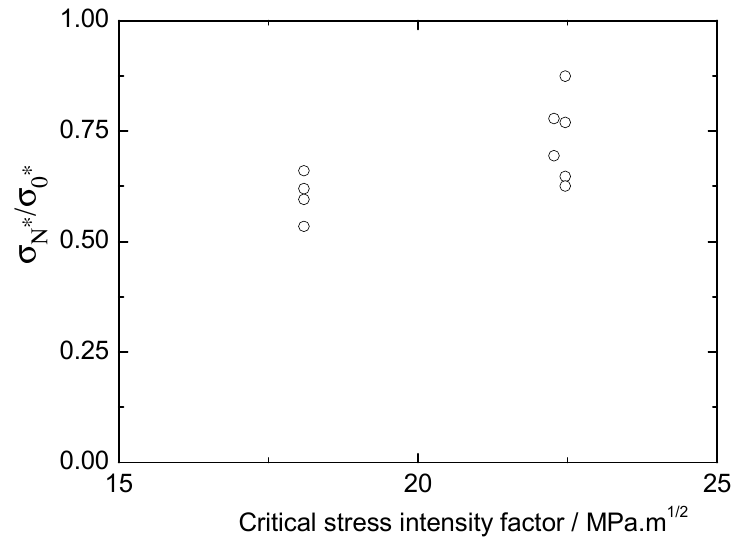
Figure 8. Correlation between the critical stress intensity factor and notch sensitivity for composite-fibre/molybdenum-matrix composites.